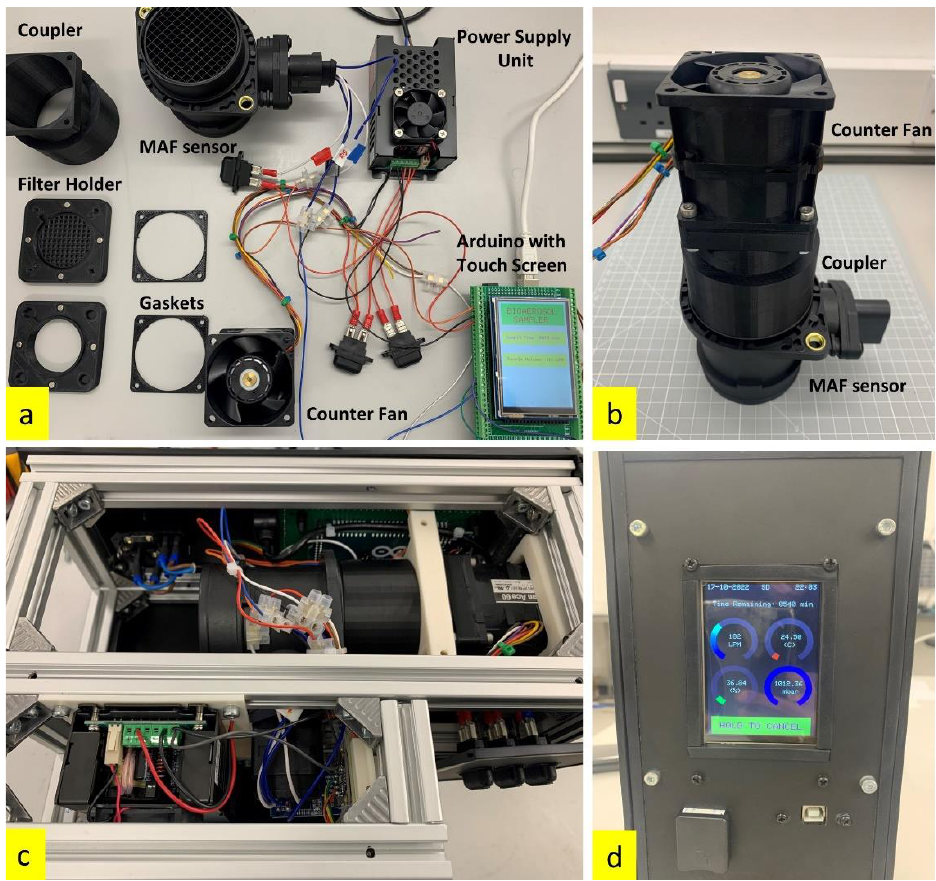
Figure 1. ( a ) Components of the bioaerosol sampler; ( b ) core of the bioaerosol sampler with the counter fan coupled to the MAF sensor; ( c ) assembled components of the bioaerosol sampler inside the housing; ( d ) touch screen GUI showing the parameters of sampling in progress. Table 1. Specifications of the bioaerosol